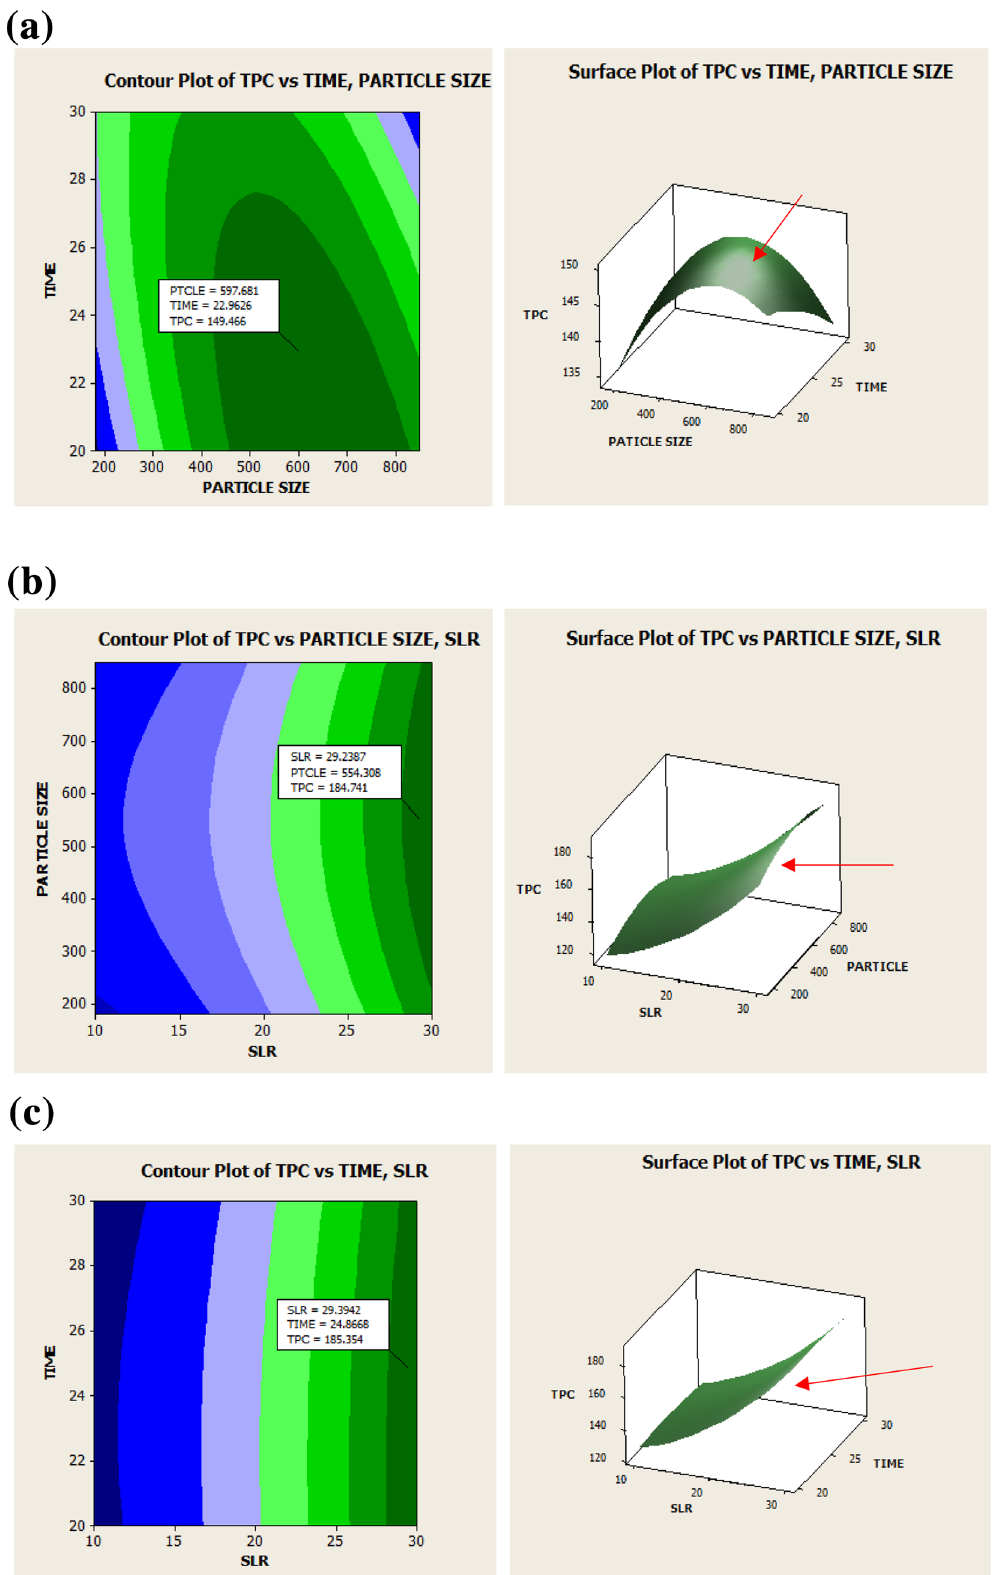
Figure 2. 2D contour plot (left) and 3D surface plot (right) showing the influence of time and particle size ( a ), time and SLR ( b ) and particle size and SLR ( c ), on TPC. The line on the surface plot demonstrating the predicted optimal